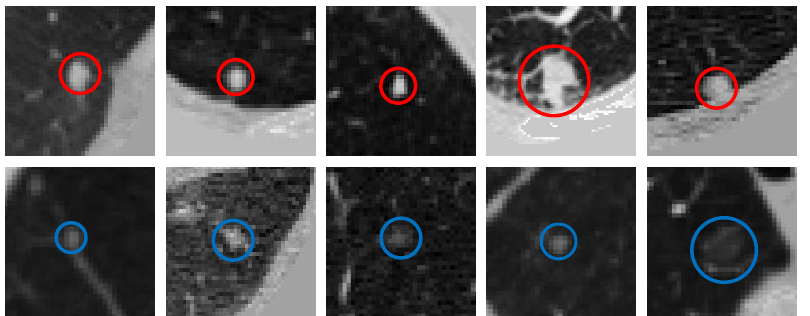
Figure 9. Visualization of labeled nodules. The first row shows the nodules correctly predicted by our MSFD-Net (red solid line circles). And the last row shows the missed nodules, of which a solid blue line circle illustrates the ground truth.